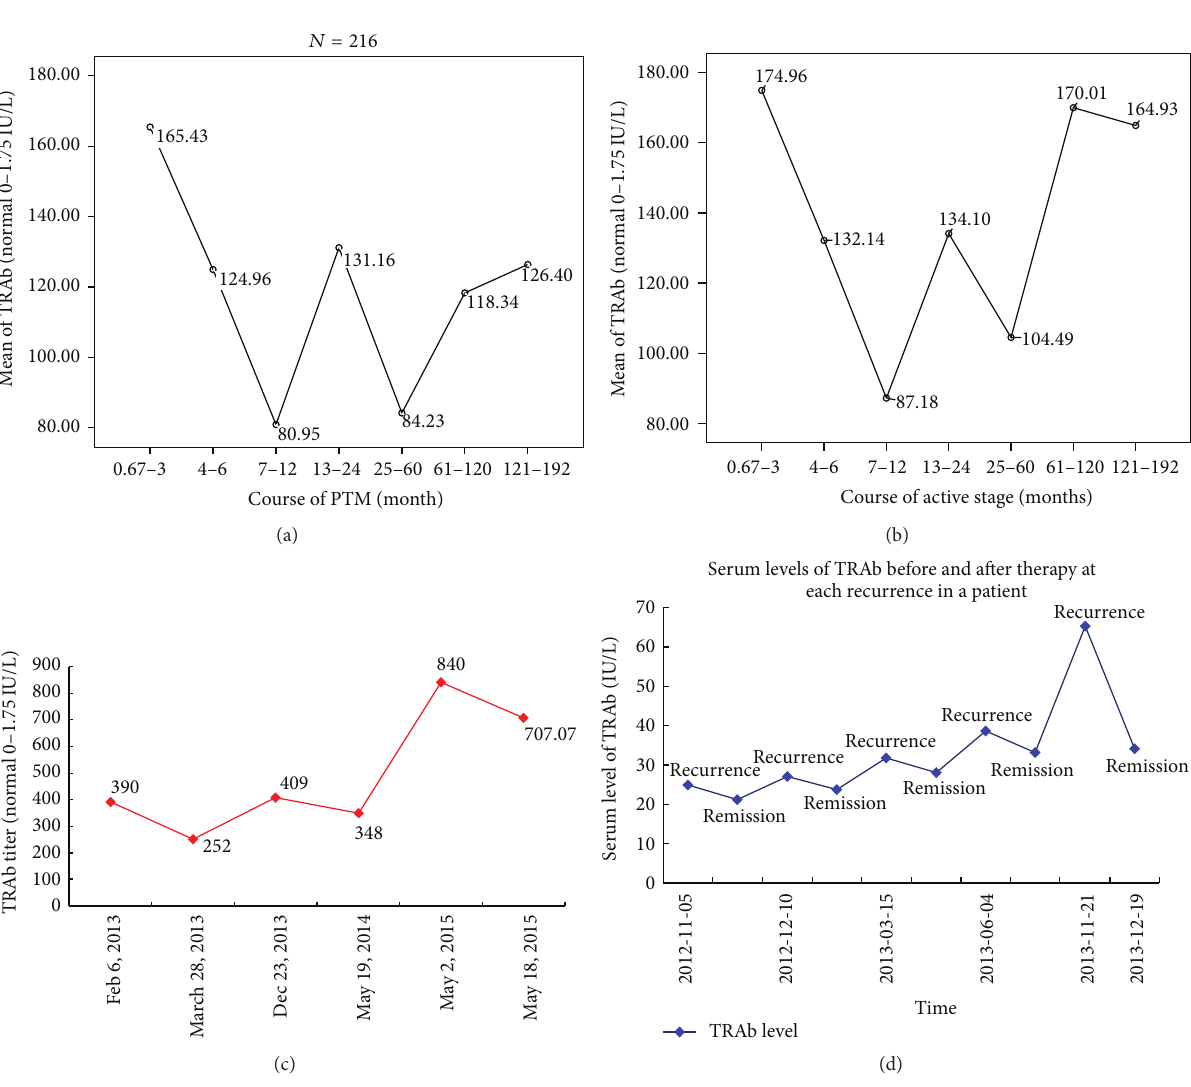
Serum levels of TRAb before and after therapy at each recurrence in a patient